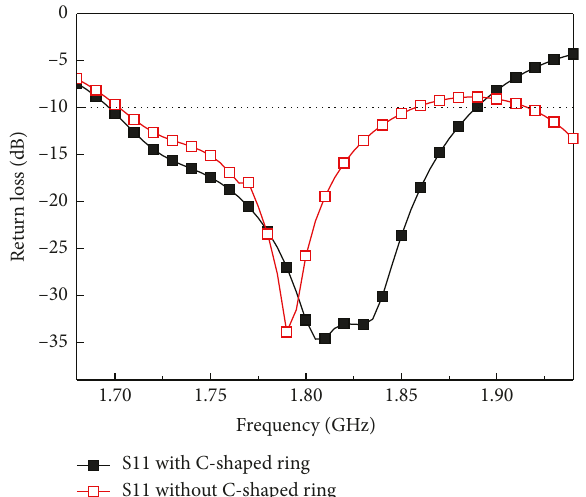
Figure 5: Simulated results with C-shaped ring.